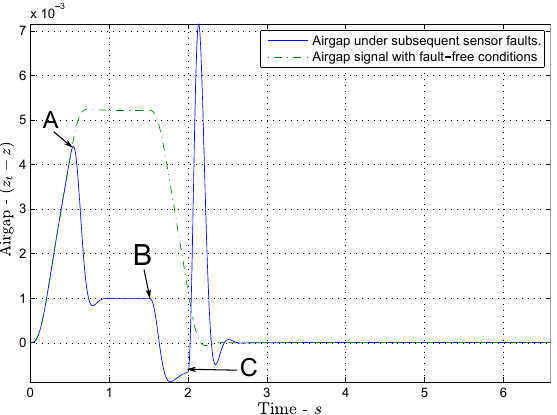
Figure 7. Airgap sensor signal with fault-free and with the fault scenario, id : 8 of Table 2.